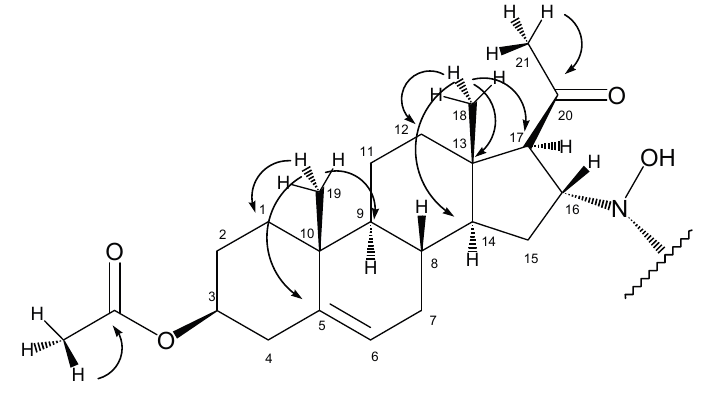
Figure 2. Some HMBC correlations of dimer 3